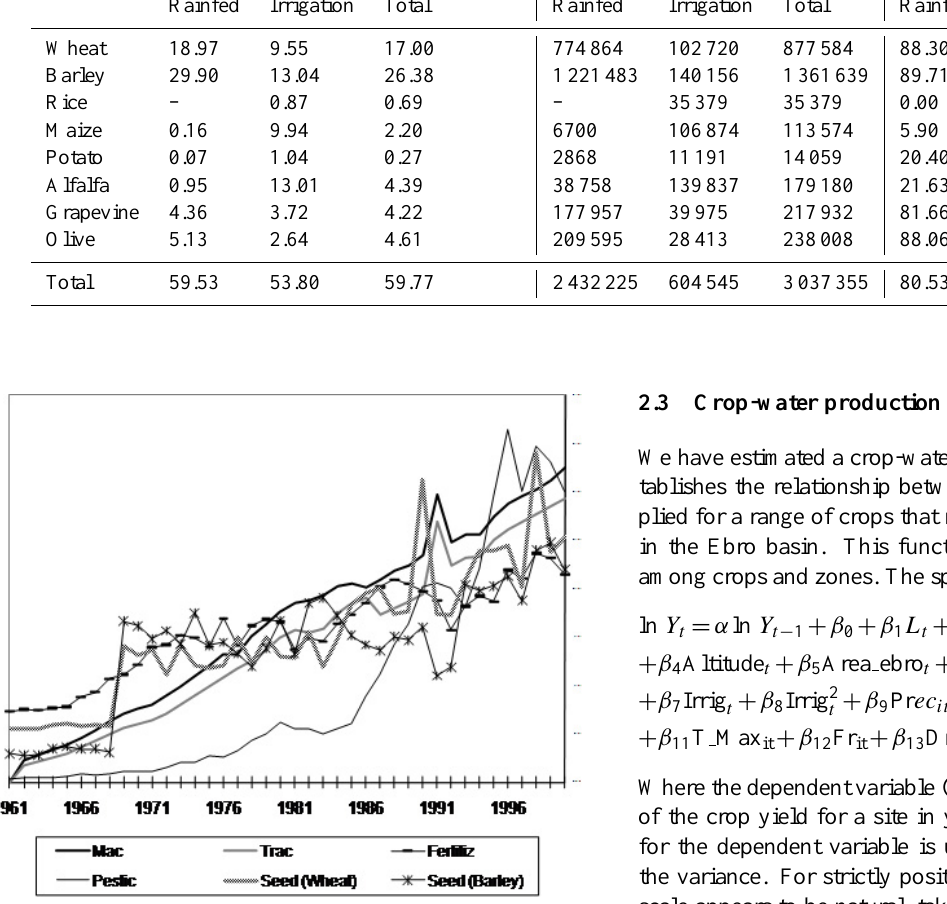
Table 1. Percentage of agricultural area for selected crops. Crop